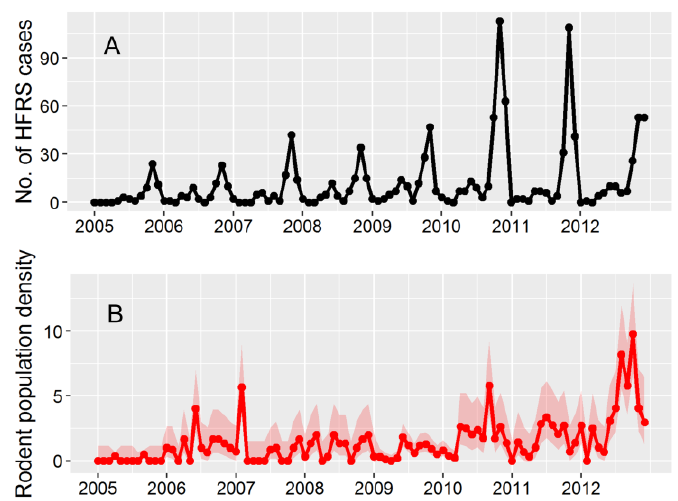
Figure 2. Epidemic pattern of hemorrhagic fever with renal syndrome (HFRS) in Hu County, 2005–2012. ( A ) Number of monthly reported HFRS cases. ( B ) The time series of Apodemus agrarius population density (capture rate); the shaded areas indicate binomial 95% confidence intervals using the Agresti-Coull method. Capture rates are expressed as number of rodents caught per 100 trap-nights.